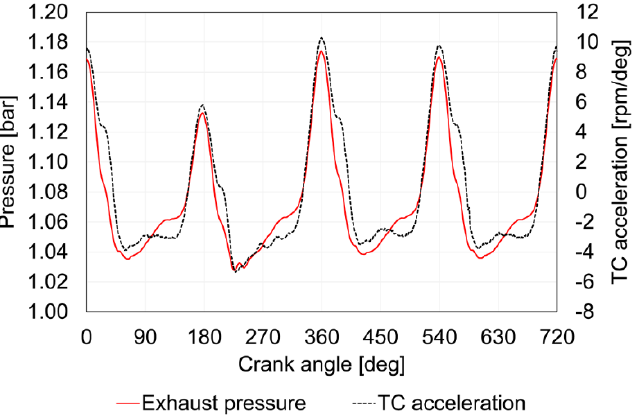
Figure 1. Example of the pressure in the exhaust manifold vs. turbocharger (TC) acceleration: numerical results for a four-cylinder engine (data from [29]).